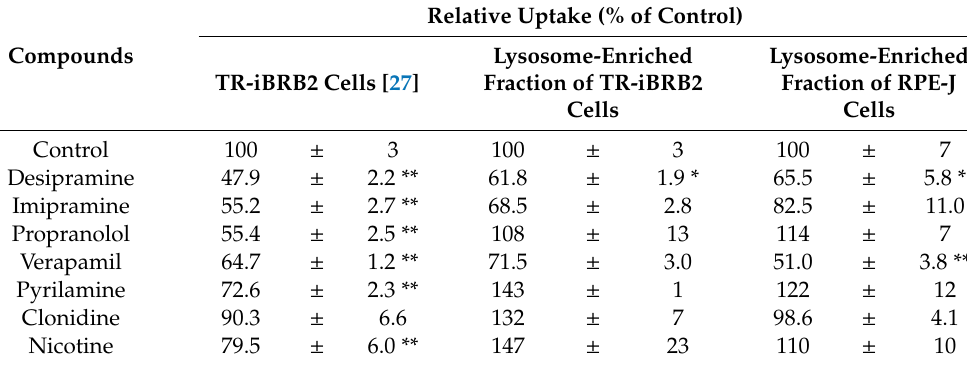
Table 2. Inhibitory e ff ect of EFV